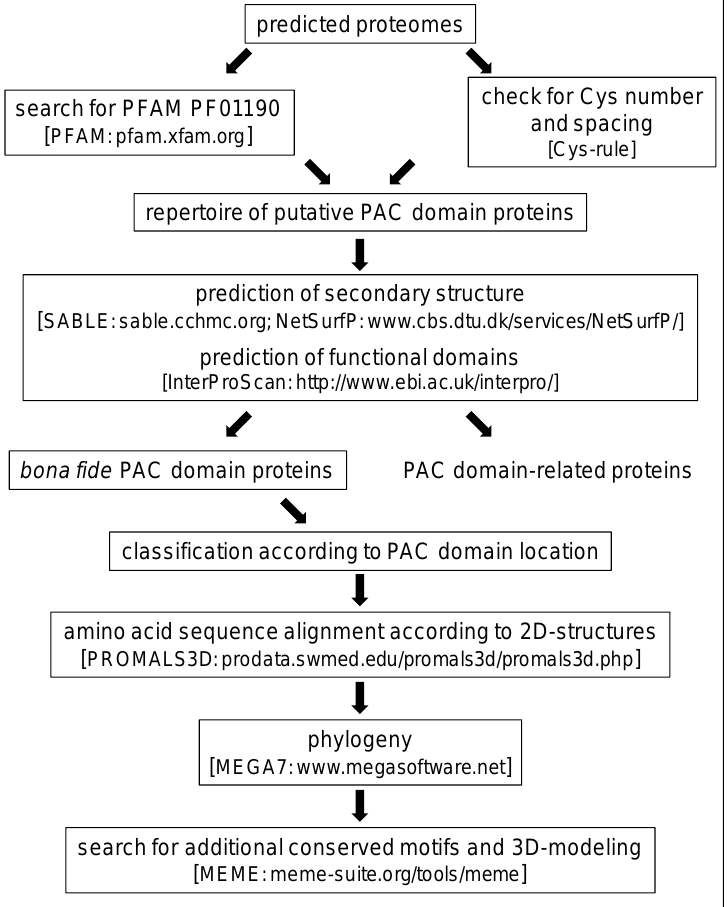
Figure 1. Pipeline for Proline-rich Arabinogalactan protein and Conserved Cys (PAC) domain protein identification and phylogeny. The name of the bioinformatics programs and resources used at each step are indicated in brackets. Table 1. Five features of a bona fide PAC domain.